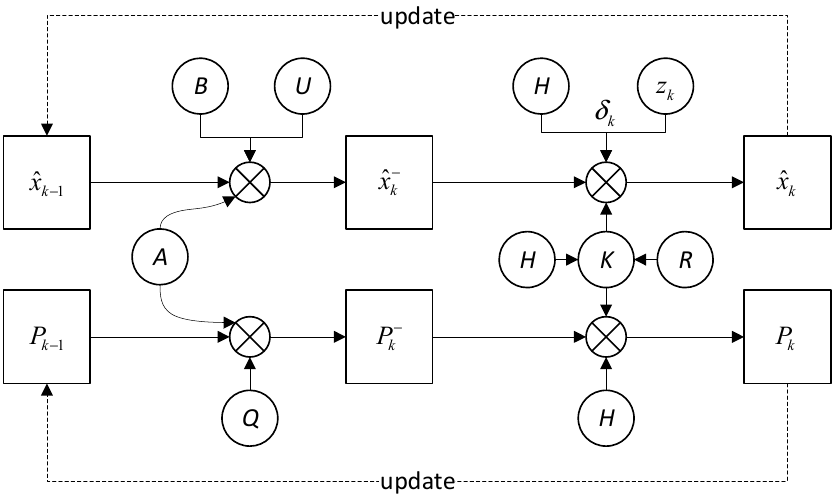
Figure 3. Schematic diagram of the Kalman filtering algorithm.